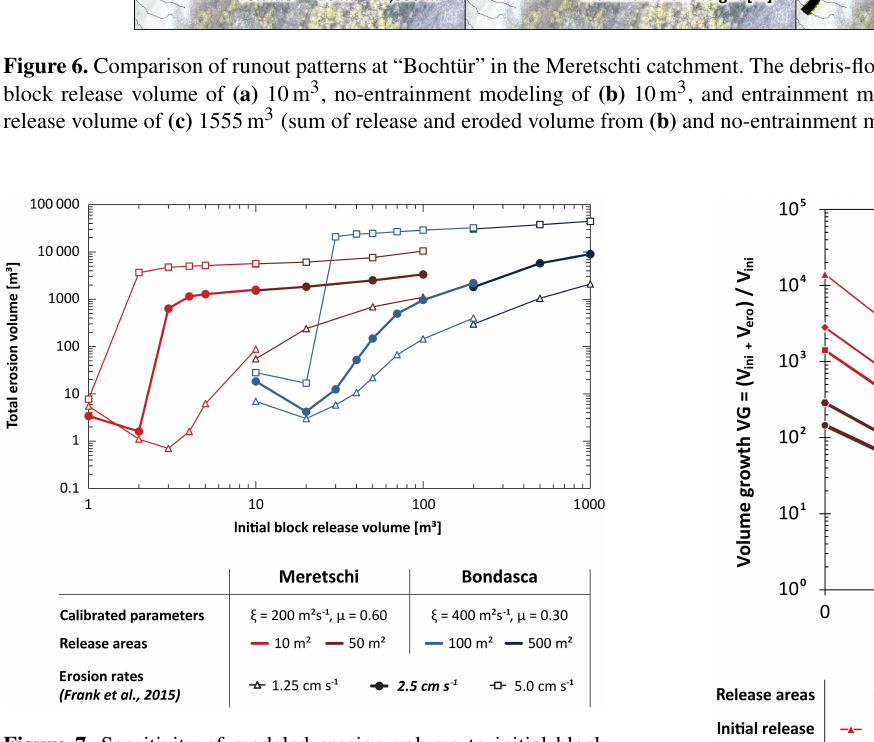
Figure 7. Sensitivity of modeled erosion volume to initial block release volume in the Meretschibach and Bondasca catchments.